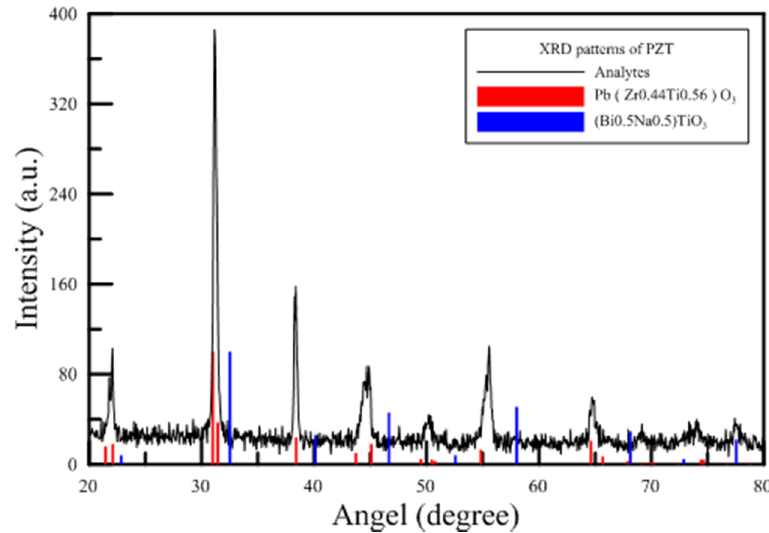
Figure 6. XRD patterns of the present PZT.